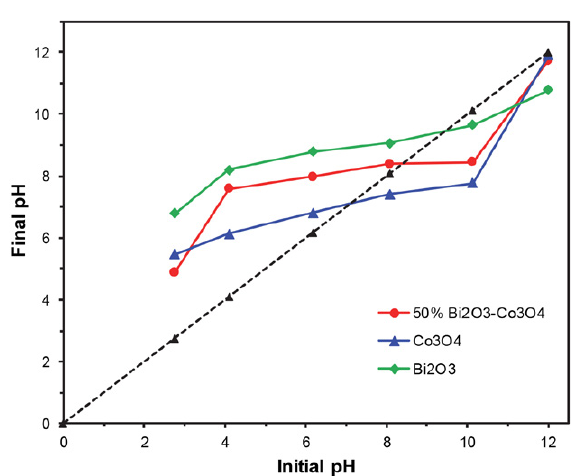
Fig. 9. UV–vis spectra of AO7 catalytic degradation on 50% Bi 2 O 3 - Co